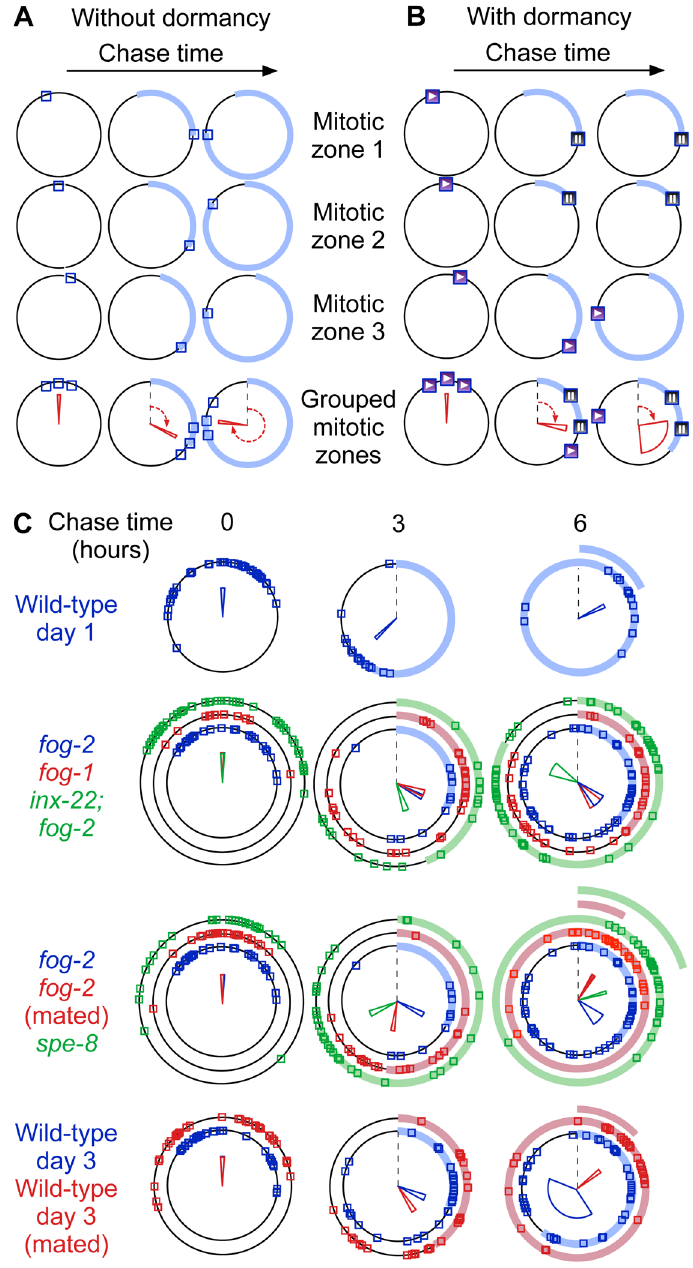
Fig 6. Slower average cell cycle progression and loss of synchrony in gonads with reduced reproductive activity. (A, B) Principle of EdU pulse chase analysis. Three fictitious mitotic zones cycle steadily (A) or stochastically enter a dormant state (B; play and pause symbols within the squares). The position of each square on the circle represents mitotic zone cell cycle progression (progression from time of labeling highlighted by a colored band). A full revolution on the circle corresponds to all cells in the mitotic zone having undergone a full cycle. The red wedge in the bottom row shows average cycle progression (angle shown by red arrows) and the amount of dispersion between mitotic zones (width of the wedge, set to the inverse of the magnitude of the resultant computed as the vector sum of individual gonad positions). (C) Analysis of cell cycle progression after EdU pulse-chase. Mitotic zones from virgin females or old wild-type hermaphrodites lose synchrony at later chase times, as shown e.g. by wider wedges (virgin fog-2 data is repeated in rows 2 and 3 to facilitate comparisons). See also S5 Fig, S5 Table, S1 Movie, S1 Dataset and S1